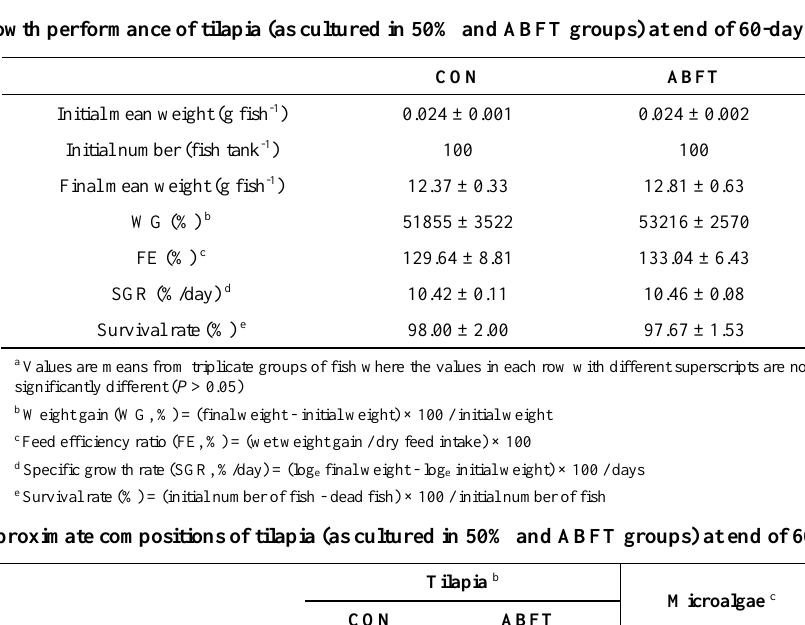
Table 1. Growth performance of tilapia (as cultured in 50% and ABFT groups) at end of 60-day experiment a